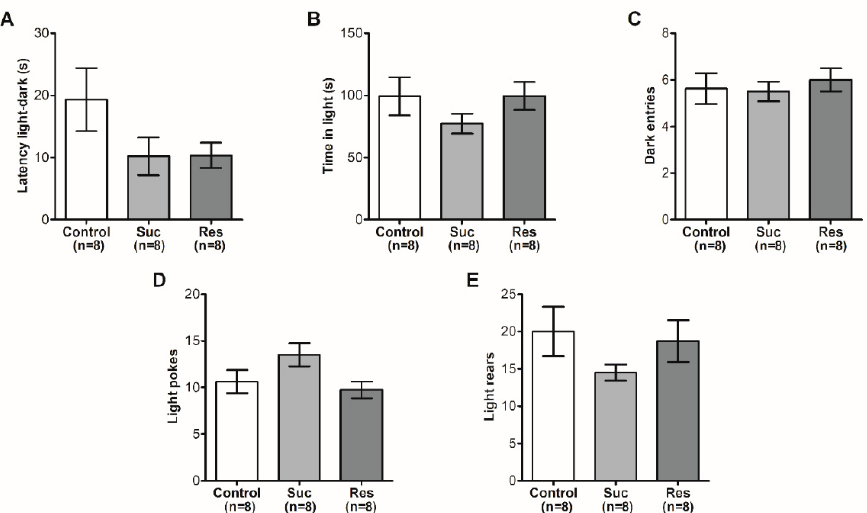
Figure 2. Sucrose exposure in late adolescence does not induce anxiety in the light–dark box test. ( A ) Latency to enter in the dark chamber. ( B ) Time spent in the light chamber. ( C ) Number of entries to the dark compartment. ( D ) Risk behavior measured by the number of pokes to light compartment. ( E ) Number of rears in the light chamber. These were analyzed via One-Way ANOVA followed by a Newman–Keuls test.